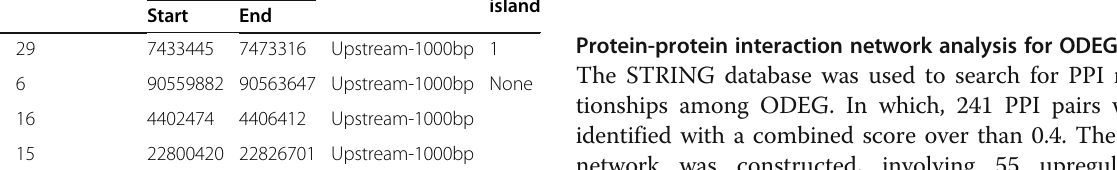
Table 2 Gene location information list Gene Chromosome